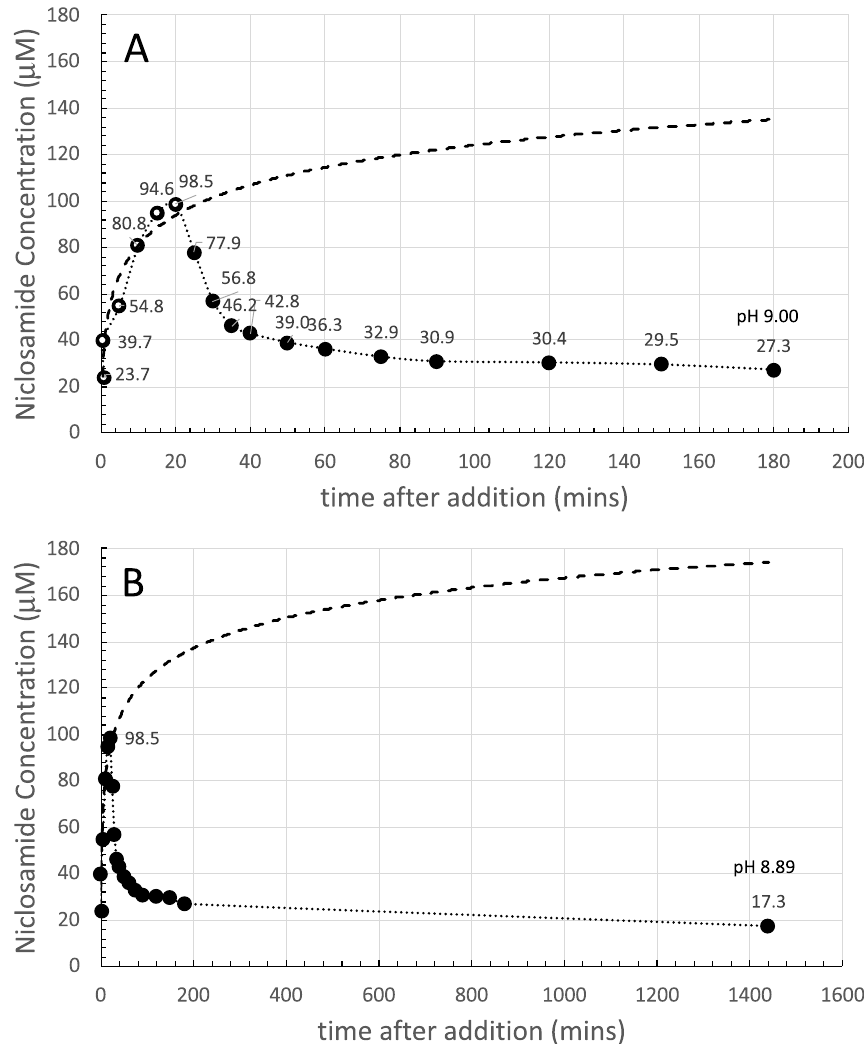
Fig. 16 Dissolution of 1 mM Yomesan in nominally 9.23 Tris-buffered saline solution (TBSS): supernatant niclosamide concentration (µM) vs. time after addition (mins), baseline-corrected, 30 s corrected for, A 0–180 min. B Same data including day 2. Dashed line is the logarithmic fit to the initial (white symbol) dissolution; dotted line is to guide the